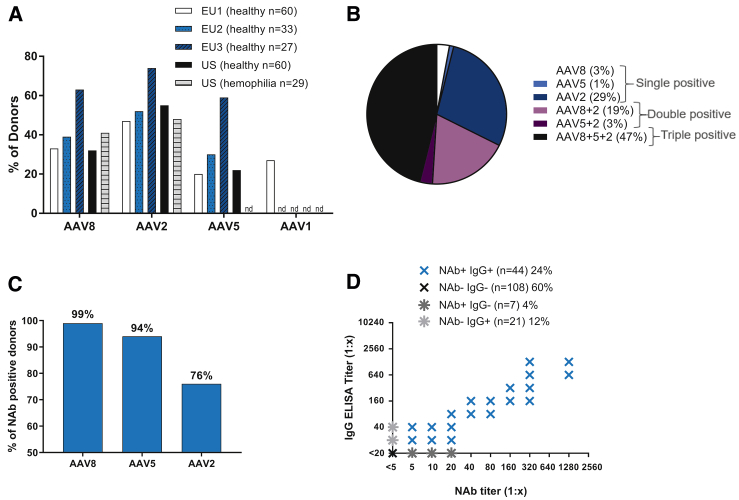
Co-prevalence of Antibody Responses against Different AAV Serotypes(A) Prevalence (% of donors) of NAbs against AAV8, AAV2, AAV5, and AAV1 in healthy donors and patients with hemophilia B from different regions. nd, not determined. (B) Co-prevalence (% of donors) of NAbs against AAV8, AAV2, and AAV5. The graph includes all donors from the EU1, EU2, EU3, and US2 cohorts from (A) that were positive for at least one of the serotypes. (C) The proportion of NAb-positive donors with IgG, suggesting that NAbs against AAV8 and AAV5 are always class switched. IgG ELISA was carried out with a starting dilution of 1:5. (D) Correlation between NAbs and IgG against AAV5 (linear regression: n = 180, R2 = 0.8652, p < 0.0001).